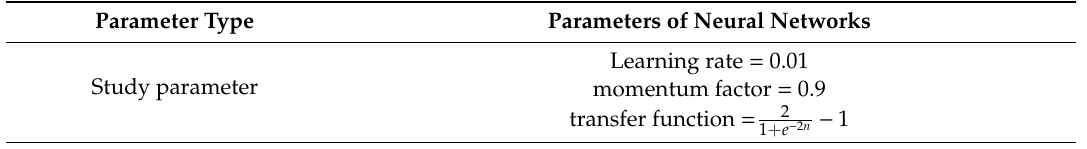
Table 4. Model parameters used for the neural network models.